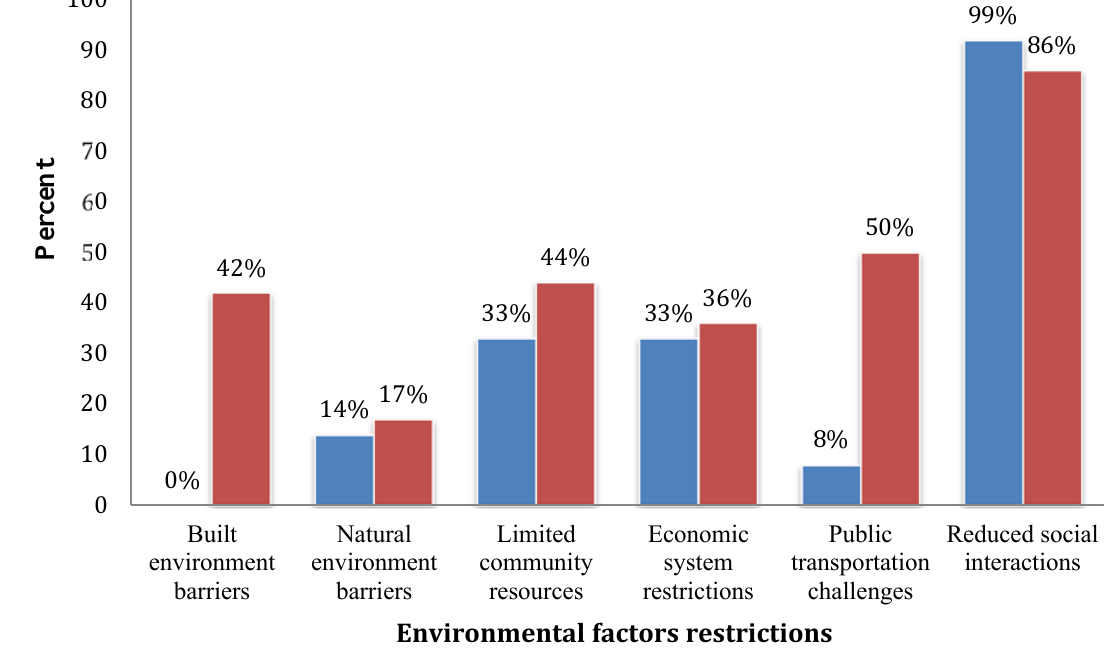
Figure 1. Percent of environmental factors restrictors to occupational participation of men and